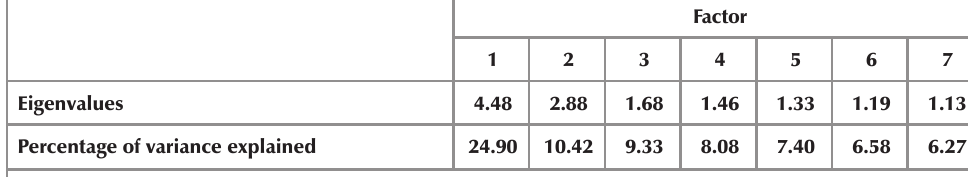
Rotated factor loadings* and factor scores of managerial responses to risk for sample commercial horticulture farmers in the three zobatat of Eritrea, 2002/03